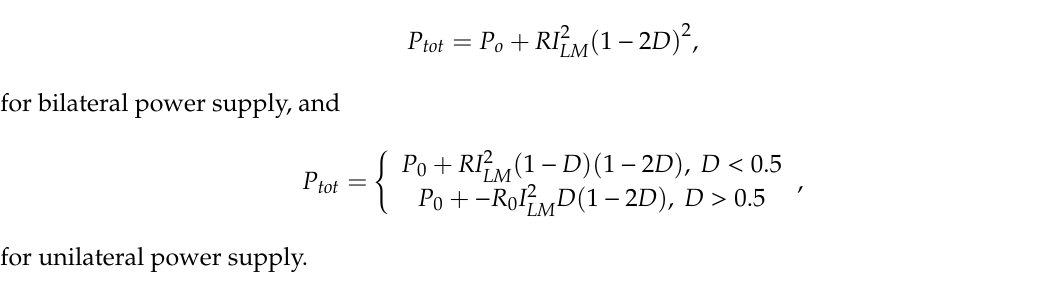
Figure 10. Measured and calculated power consumption: (a) measured, bilateral power supply; (b) measured, unidirectional supply and C 3 = 2.07 μF; (c) measured, unidirectional supply and C 3 = 24.3 for bilateral power supply, and μF; (d) calculated, ideal case augmented with quiescent consumption P 0 (e) calculated, unilateral power supply and perfect absorption of negative supply currents, raised with quiescent consumption P 0 (ideal dissipative method) .